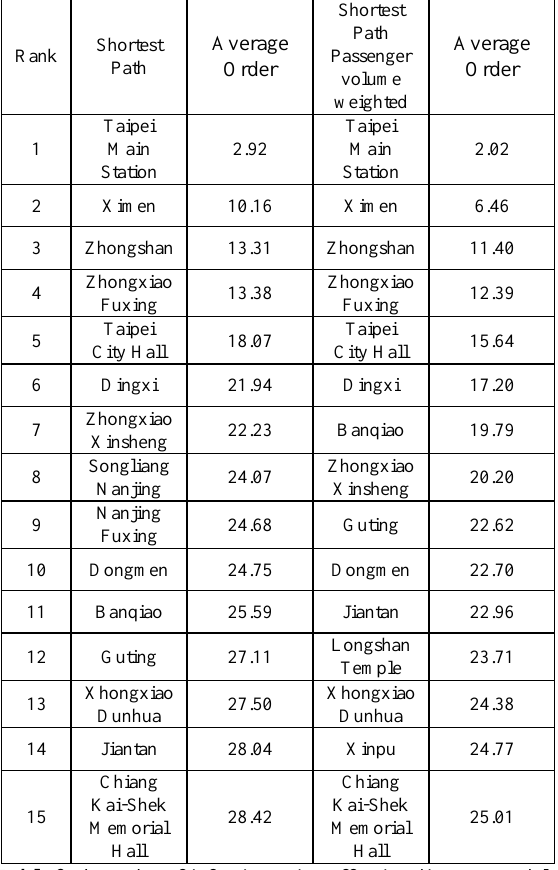
Table 3 . the order of infection using effective distance models. The results indicated that the hub station, Taipei main station, was one of the earliest to become infected, probably due to its extremely high passenger volume. Moreover, it is also a major transfer station to railway, high speed rail, and buses, which indicates that the infection rate should be even higher than